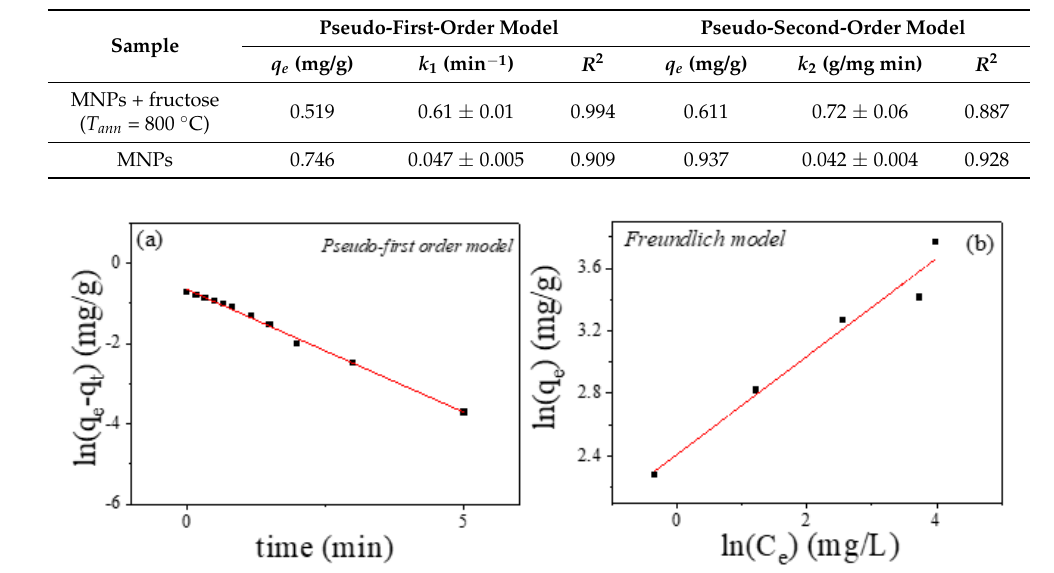
Table 3. Kinetic parameters for adsorption of Cr (VI) in the presence of the annealed sample ( T ann = 800 °C) and initial MNPs.